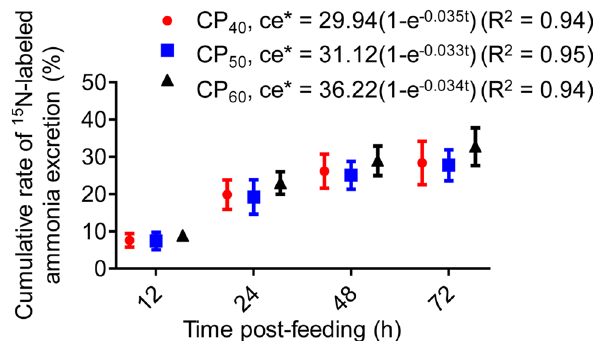
Figure 8. Cumulative rate of 15 N-labeled ammonia excretion (ce*, %, expressed as the percentage of 15 N in the assimilated feed) in juvenile Sagmariasus verreauxi . Lobsters were reared at 21 °C and fed 15 N-labeled feeds at 1.5% body weight at three crude protein levels: 40%, 50% and 60%, corresponding to CP 40 , CP 50 and CP 60 treatments, respectively. All data represent mean ± standard error (SE) of 6 individuals.